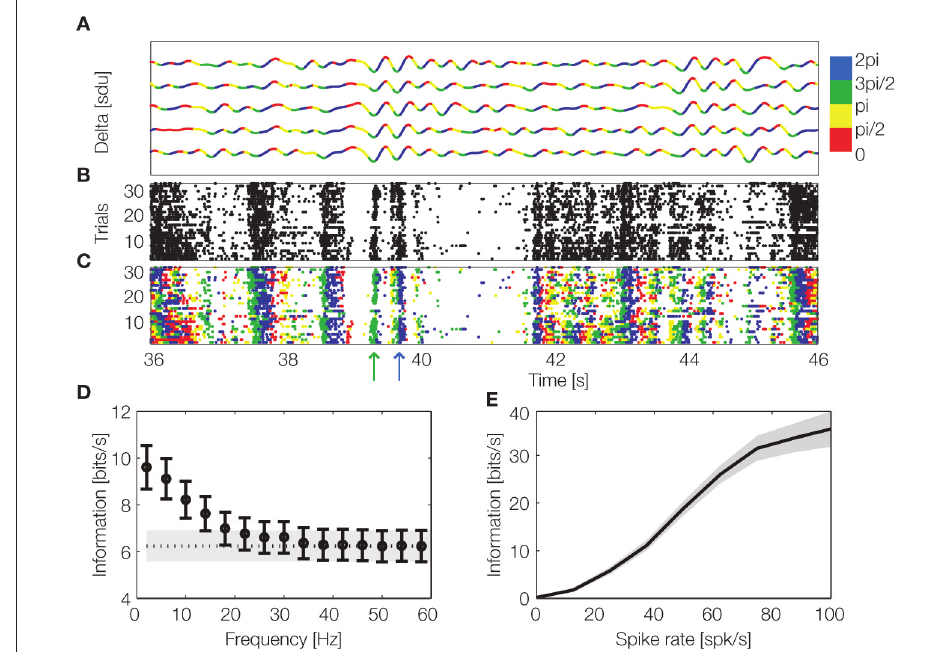
Figure 5 | Encoding of information by spike count and phase of firing. LFPs and spiking activity were recorded from primary visual cortex of anesthetized macaques during binocular presentation of a naturalistic color movie. (A) Delta band (1–4 Hz) LFP traces from an example recording site during five repetitions of the same visual stimulus. The line is colored according to the phase quadrant of the instantaneous LFP phase. (B) Multiunit spiking activity from the same site over thirty repetitions of the same movie stimulus. (C) The same multiunit activity as in (B) , but with spikes colored according to the concurrent instantaneous LFP phase quadrant at which they were emitted (phase of firing). The movie scenes indicated by green and blue arrows can be better discriminated by considering phase of firing (colored spikes) than by using the spike counts alone (black spikes). (D) Black circles show information carried by the LFP phase of firing as a function of the LFP frequency (mean ± SEM over the entire dataset). The black dashed line shows the spike count information (averaged over the dataset, with grey area showing SEM). For LFP frequencies below 20 Hz the phase of firing carries more information than the spike count. (E) Information carried by delta band phase of firing was calculated for movie scenes eliciting exactly the same spike rate and was plotted as a function of the elicited spike rate. This shows that the information carried by phase of firing is not redundant with spike rate, since it is able to disambiguate stimuli eliciting exactly the same spike rate. Figure reproduced (with permission) from Montemurro et al.